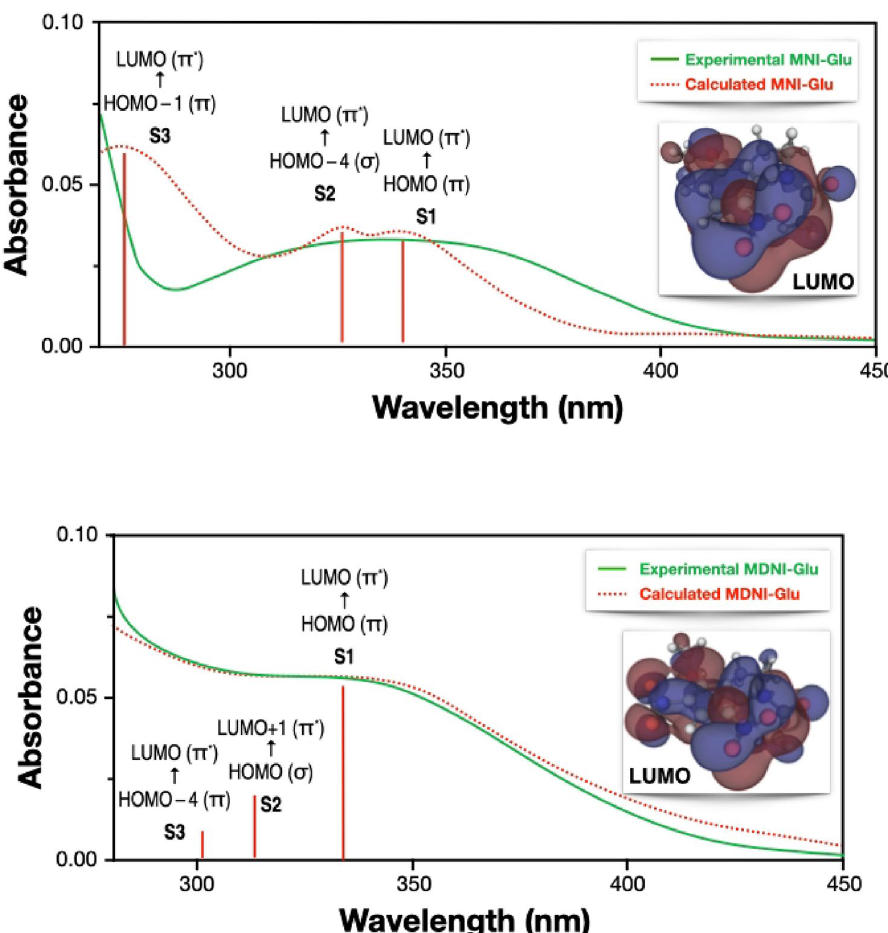
Figure 7. Comparison of the experimental (green, solid) and calculated (red, dashed) UV–Vis spectra of ( a ) MNI (top panel) and ( b ) MDNI (bottom panel). The calculated spectra are obtained by applying a Lorentzian broadening to the ωB97X-D/def2-TZVP electronic transitions, also reported as red vertical lines. The canonical π * lowest unoccupied molecular orbitals involved in the bright electronic transitions are also reported. The experimental spectra have been obtained in water (pH = 7.39 with NaHCO 3 ), at a concentration of 0.074 mM and using radiation at 350 nm as explained in Ref. 36 .